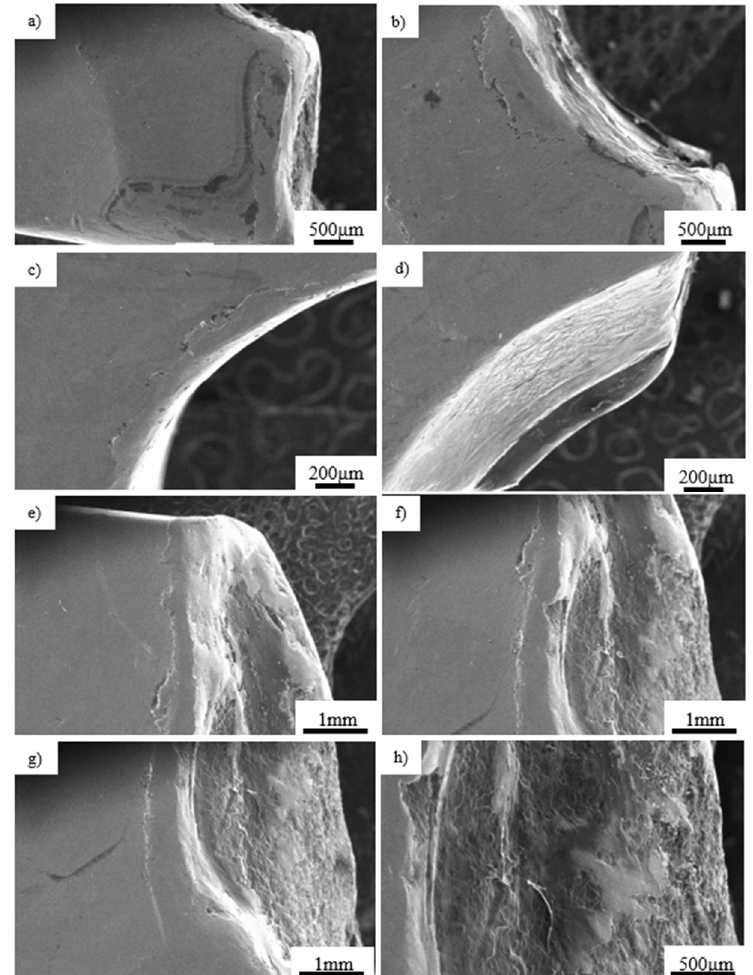
Figure 15. Microscopic observations of the fracture surface of the steel implant: crater formed around the threaded hole ( a ); cracks propagating from the crater along the edge of the hole ( b , c ); scratches inside the nonthreaded part of the hole ( d ); numerous cracks on edges of the second part of the fractured implant ( e – g ); smooth surfaces of the fracture edge caused by friction of one part of the broken implant over another ( h ).